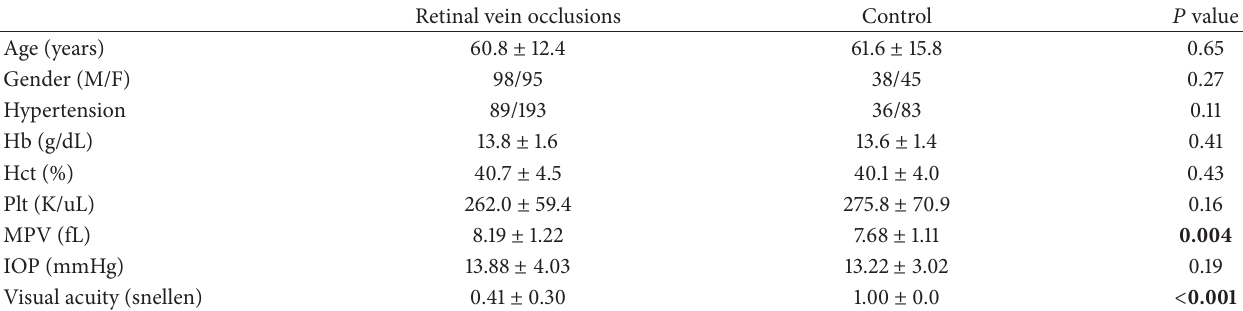
Table 1: The demographic and clinical features of the RVO and control